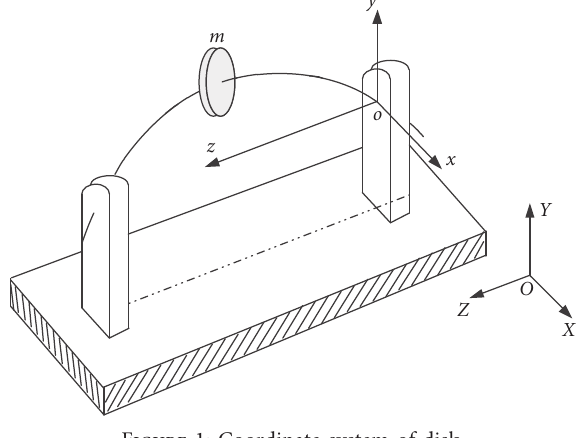
Figure 1: Coordinate system of